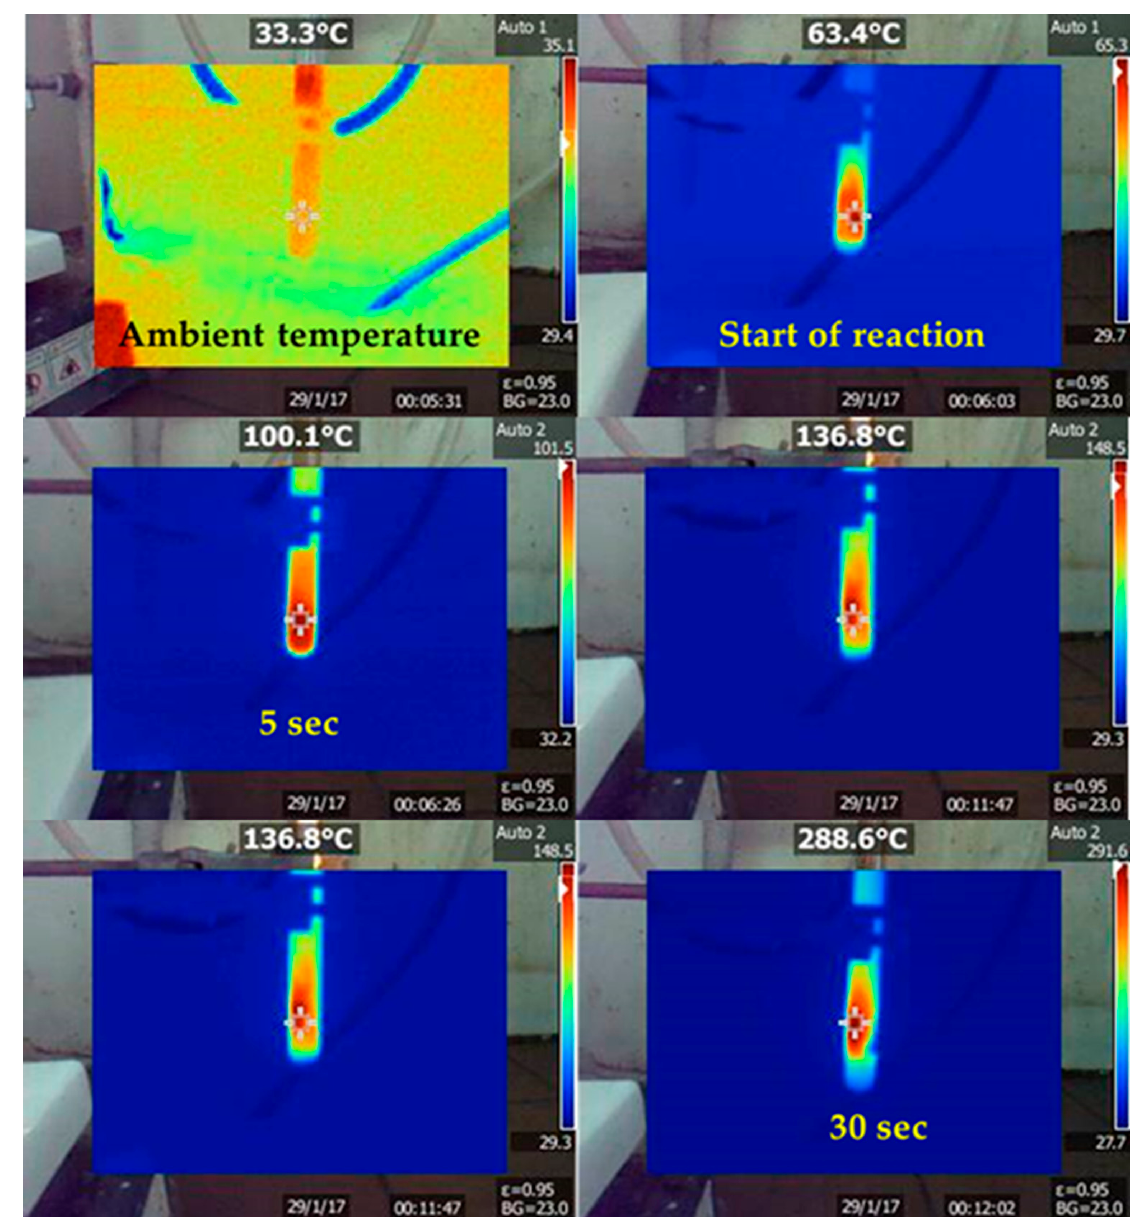
Figure 2. Temperature profile of the hypergolic reaction over time as depicted with a digital thermal camera. The temperature raised progressively from ambient to a maximum of nearly 300 ◦ C within 30